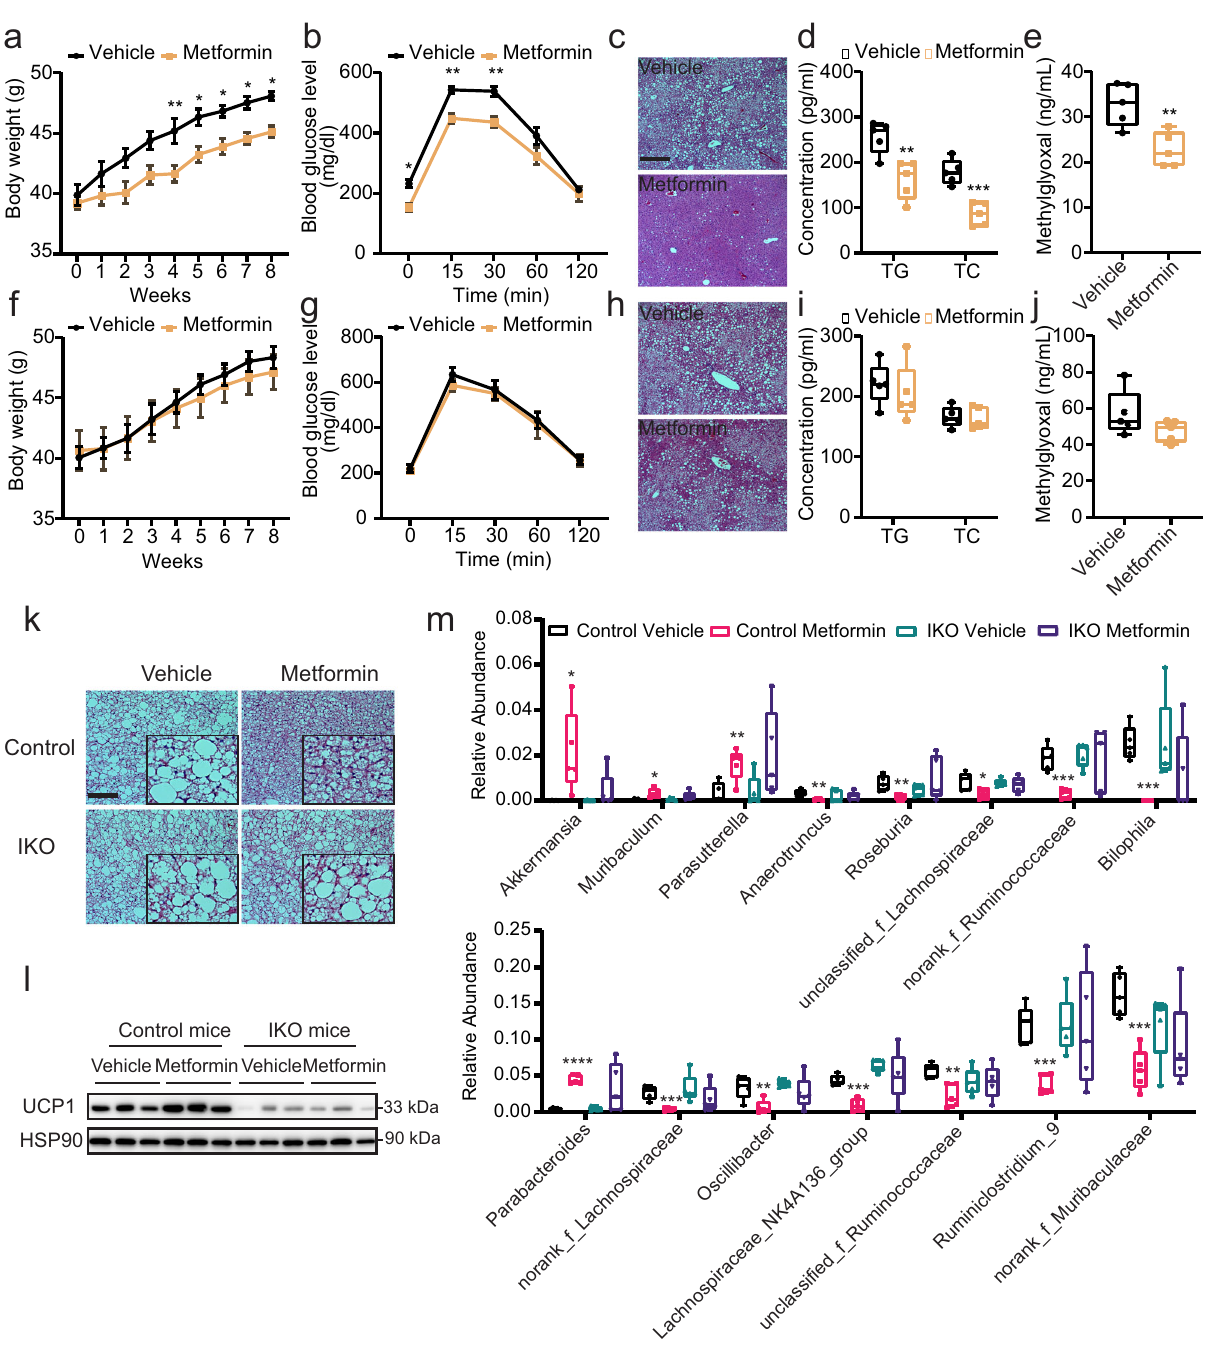
Fig. 4 The therapeutic effects of metformin on metabolic disorders depend on intestinal AMPK. DIO AMPK α 1 fl / fl (Control; a – d ) and AMPK α 1-IKO ( e – h ) mice were orally garaged with metformin (100 mg/kg) once daily for 8 weeks. a , f Body weights of mice during metformin treatment ( n = 7